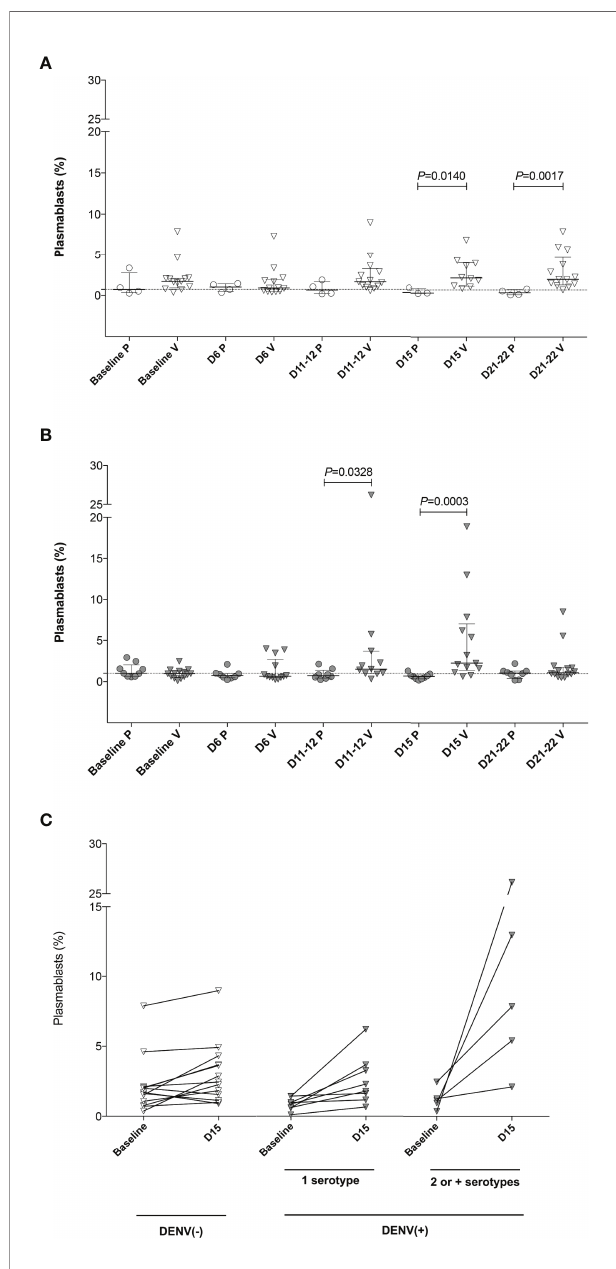
FIGURE 4 | Plasmablast expansion (as the percentage of CD20 - CD27 + CD38 + cells among the CD19 + population) after Butantan-DV vaccination. Results are presented as pooled total plasmablast cells analyzed in a Boolean analysis. (A, B) Frequency of plasmablast in fresh blood from DENV ( – ) (A) and DENV(+) (B) volunteers at baseline and days 6, 11-12, 15 and 21-22 post-immunization. D, days post-vaccination. P, placebo. V, vaccinee. Horizontal bars represent median and interquartile range. Statistical analysis was performed using a non-paired t test. (C) Difference in the frequency of plasmablast comparing the values obtained at baseline and at the peak of plasmablast expansion (D15 after Butantan-DV vaccination) in naïve [DENV ( – )] and DENV pre-exposed [DENV(+)) vaccinees. DENV(+) volunteers were divided into individuals pre-exposed to 1 or 2 or more serotypes, according to PRNT50 results to all four DENV serotypes at baseline. Data were analyzed with the Mann-Whitney U